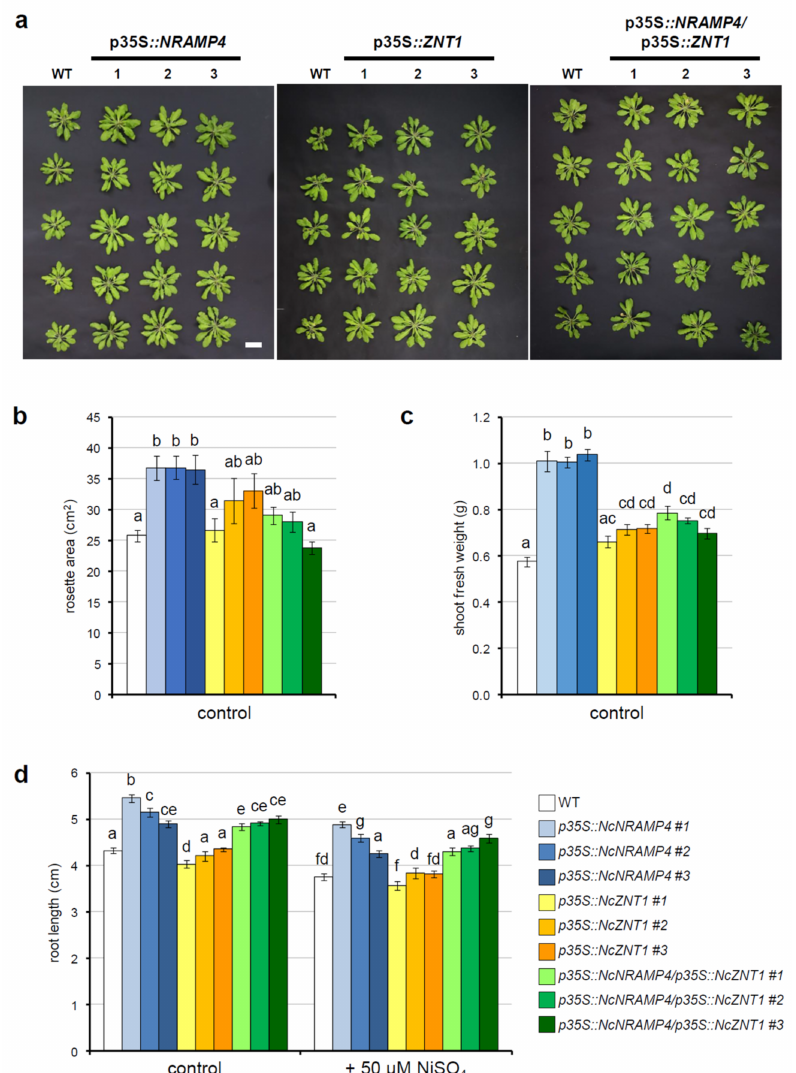
Figure 3. Effect of the expression of NcNRAMP4 and NcZNT1 in Arabidopsis thaliana Col_0 plants. ( a ) Picture of the transgenic and WT plants grown in soil under control conditions in a greenhouse under a 16 h light/8 h dark regime at 22 ◦ C/18 ◦ C (light intensity of 80 to 120 µ mol m − 2 s − 1 ). ( b ) Rosette area and ( c ) biomass were measured on four-week-old plants. ( d ) Primary root length of plants of Arabidopsis thaliana wild-type and transformed lines with NcNRAMP4 and NcZNT1 alone or in combination grown for 10 days, in vitro in Gelrite-solidified MS medium, either standard (control) or supplemented with 50 µ M NiSO 4 (Ni excess) as described in M&M. Statistical analyses were performed by two-way ANOVA ( n = 18) followed by a post-hoc Bonferroni test. Statistically significant variations, at p < 0.05, are marked by different